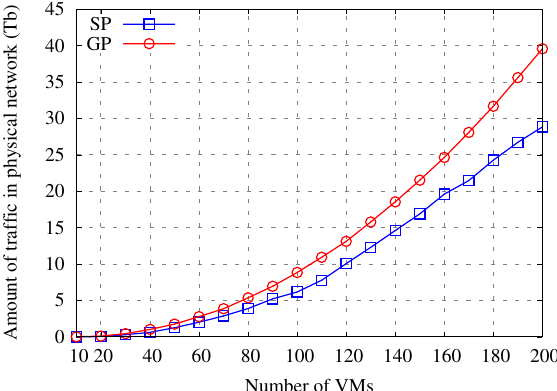
Figure 10. Amount of traffic in the physical network with respect to number of VMs.